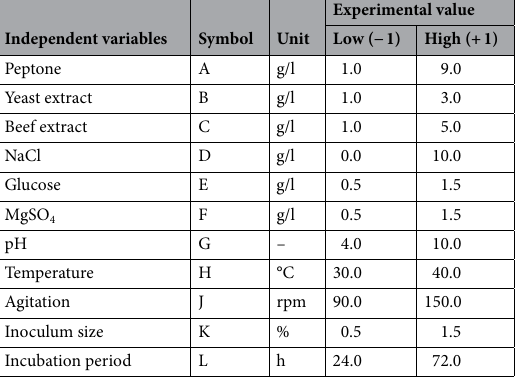
Table 4. Experimental variables used in PBD design for screening of Kocuria sp. RAM1 carotenoids production.